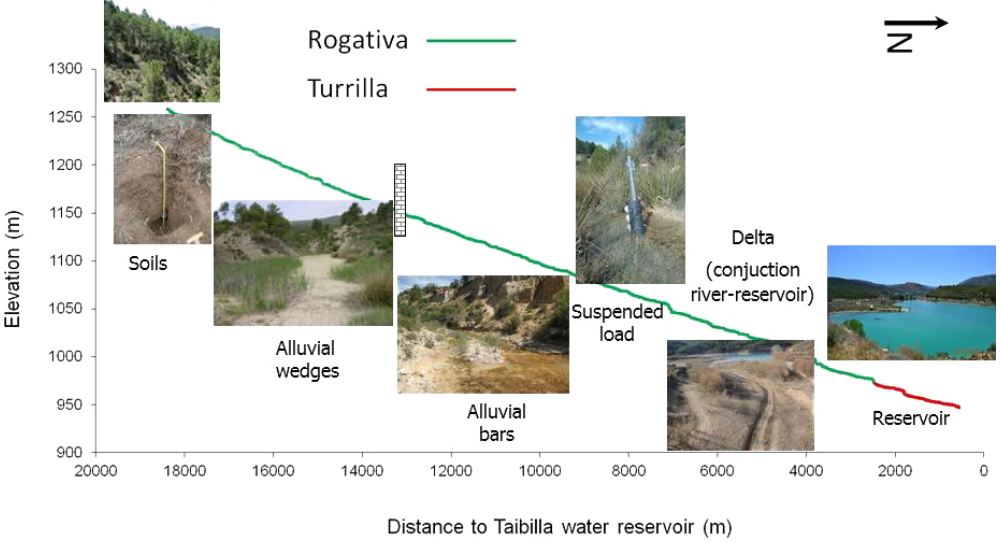
Figure 2. Sketch representing the morphological positions selected for sampling of soil and sediments. Soils were sampled all around the catchment in all the different land use classes, alluvial wedges behind check dams predominantly in the upper and middle parts of the catchment, while alluvial bars and suspended solids were sampled in the middle and downstream areas. Delta and reservoir represent sampling areas